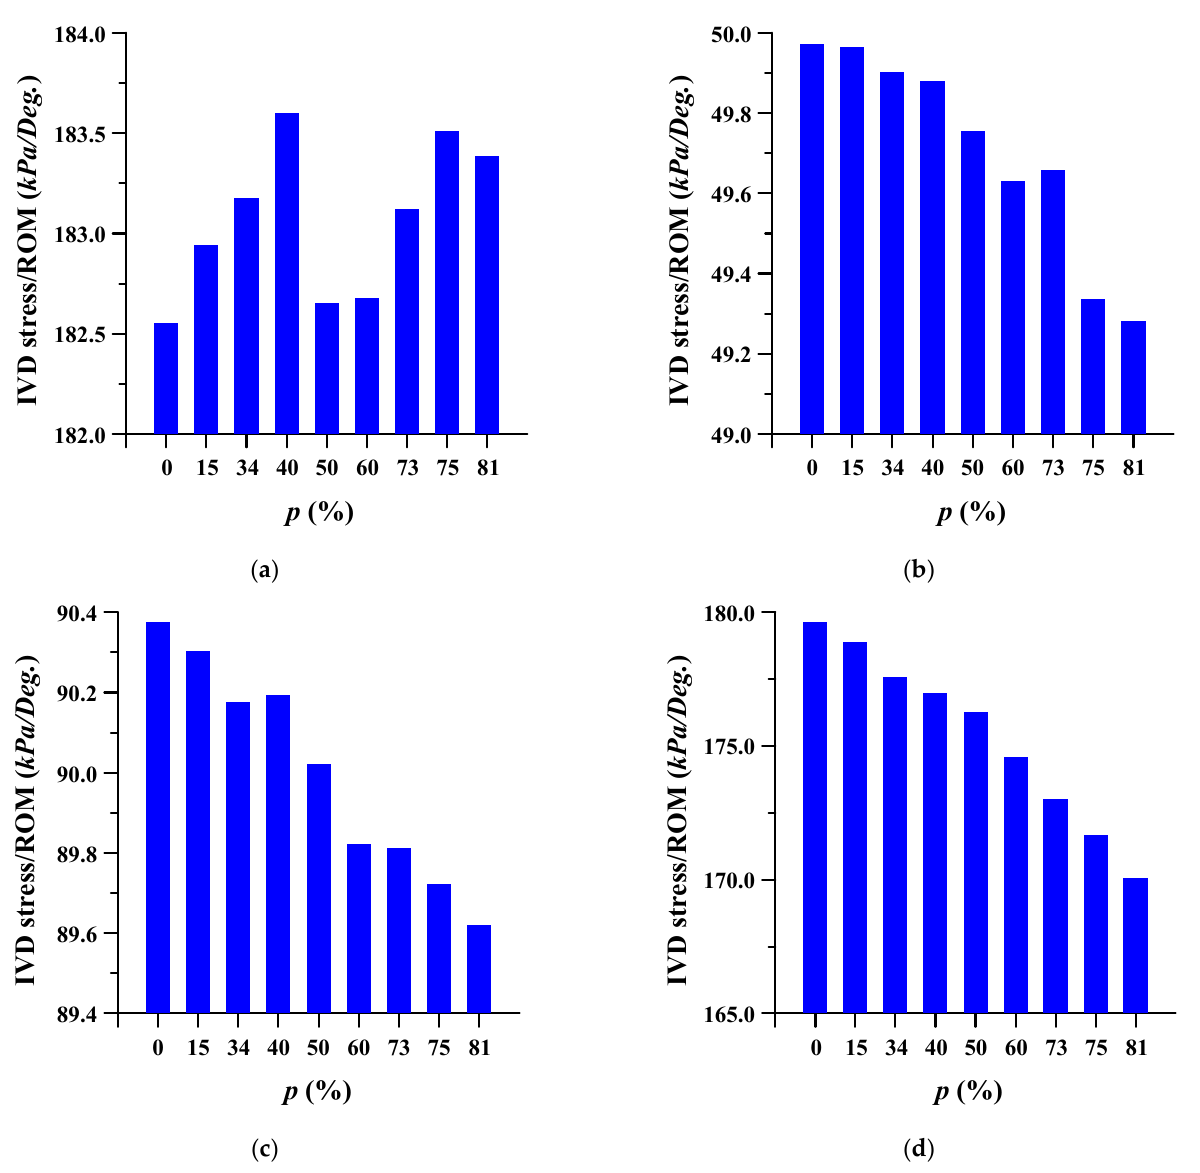
Figure 9. Equivalent stress per range of motion (ROM) of adjacent intervertebral disc (IVD) of L5-S1 at different porosities of the spinal implants in each spinal motion: ( a ) flexion; ( b ) extension; ( c ) lateral bending; ( d ) rotation.